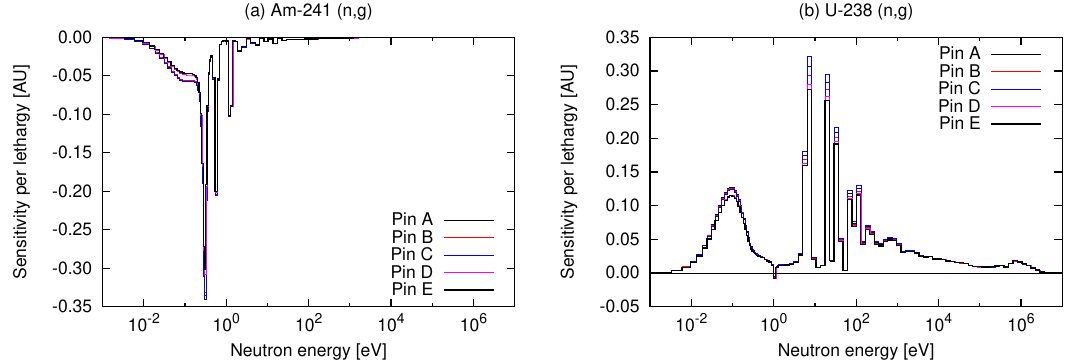
Figure 7: Sensitivity of Am-241 number density at 19.2 GWD/t to (n, γ ) cross section in the PWR